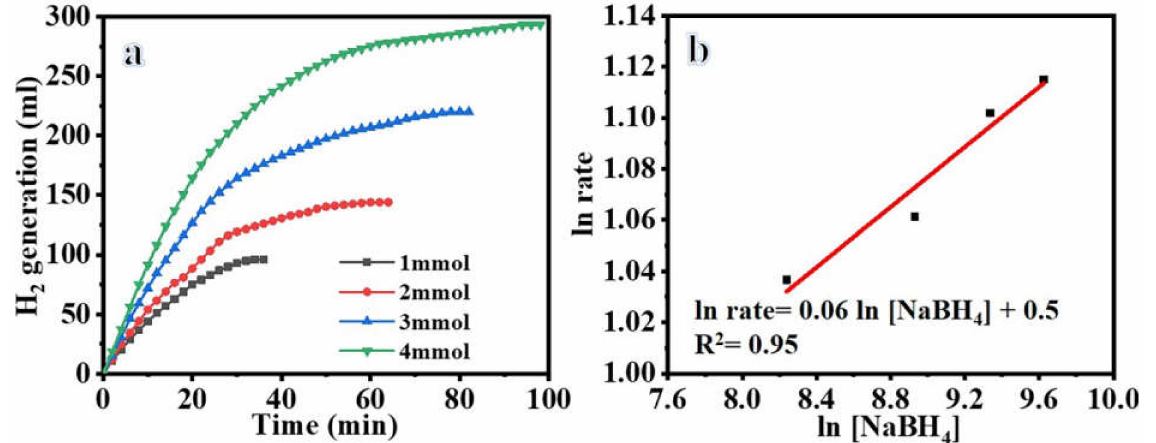
Figure 8. The effect of SBH concentration on H 2 production ( a ), and the H 2 production rate logarith- mic value vs. [SBH] concentration logarithmic value ( b ) at 100 mg catalyst and 298 K.